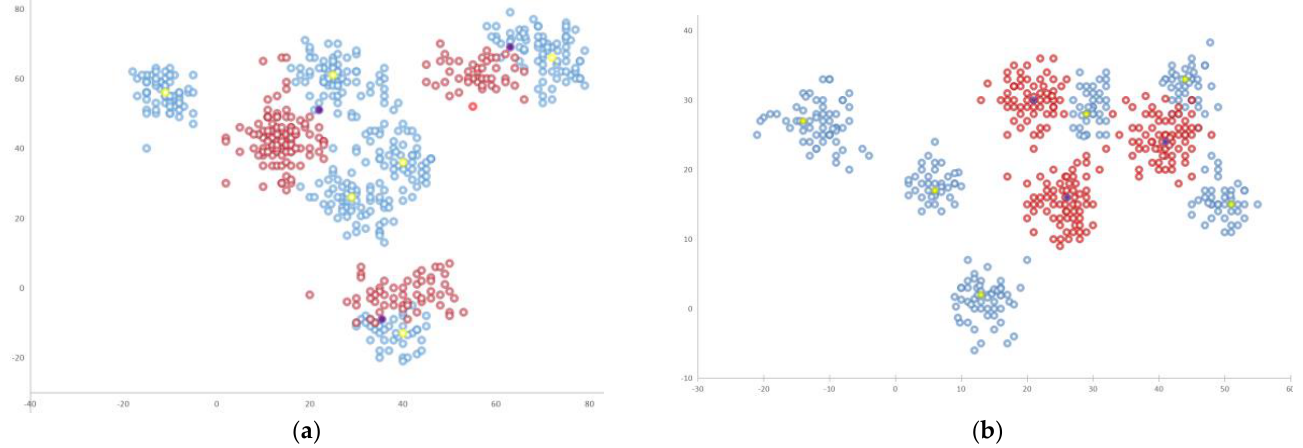
Figure 7. t-SNE diagram of embedded samples. ( a ) Domain-free adaptation for WHD-9; ( b ) Domain adaptive operation is adopted. The image features of seen and unseen classes are represented in blue and red respectively. Embedded semantic descriptors for seen and unseen classes are represented in yellow and purple respectively.